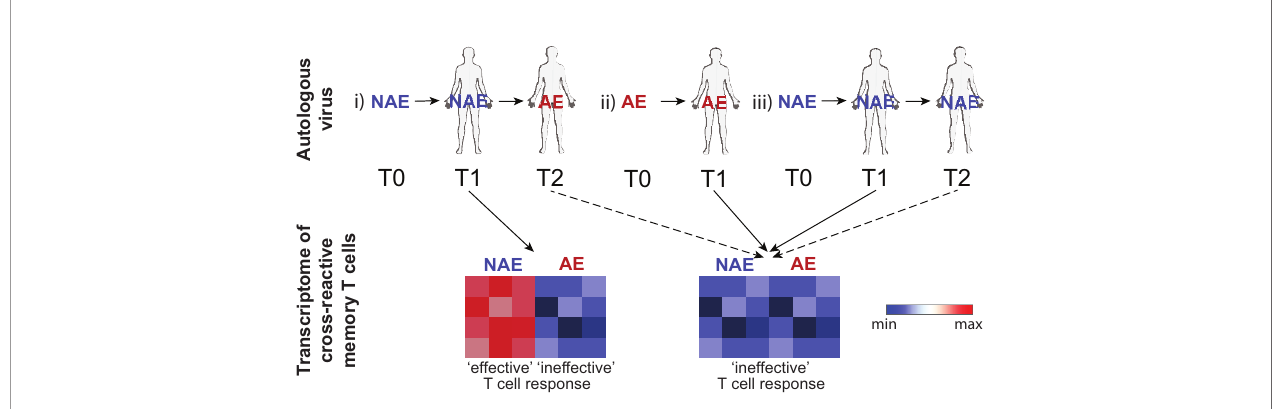
FIGURE 7 | Schematic depicts the transcriptome of cross-reactive memory T cells following peptide stimulation based on the TFV (T0), autologous (T1-2) virus at time of sampling and any future transitions. In an individual where the NAE form transitions to the AE form over time (re fl ecting strong immune pressure; scenario i), cross-reactive memory T cells that have not ‘ seen ’ the AE form of the epitope (samples tested at timepoint T1) will exhibit an RNA transcriptomic pro fi le dependent on the stimulating peptide form with activation by the NAE form re fl ecting features consistent with an ‘ effective ’ immune response. Note that timepoint T2 in this scenario was not able to be tested. Cross-reactive memory T cells previously activated by the autologous AE form of the epitope (scenario ii) at timepoint T1 would have an RNA transcriptomic pro fi le re fl ective of an ‘ ineffective ’ response irrespective of stimulating peptide form. Similarly, cross-reactive memory T cells that retain the NAE form at all timepoints (scenario iii) may also show a transcriptomic pro fi le re fl ective of an ‘ ineffective ’ response as there was not suf fi cient immune pressure to drive the NAE form to the AE form. Dotted lines indicate scenarios not tested. Blue indicates down-regulation of transcripts associated with an effective immune